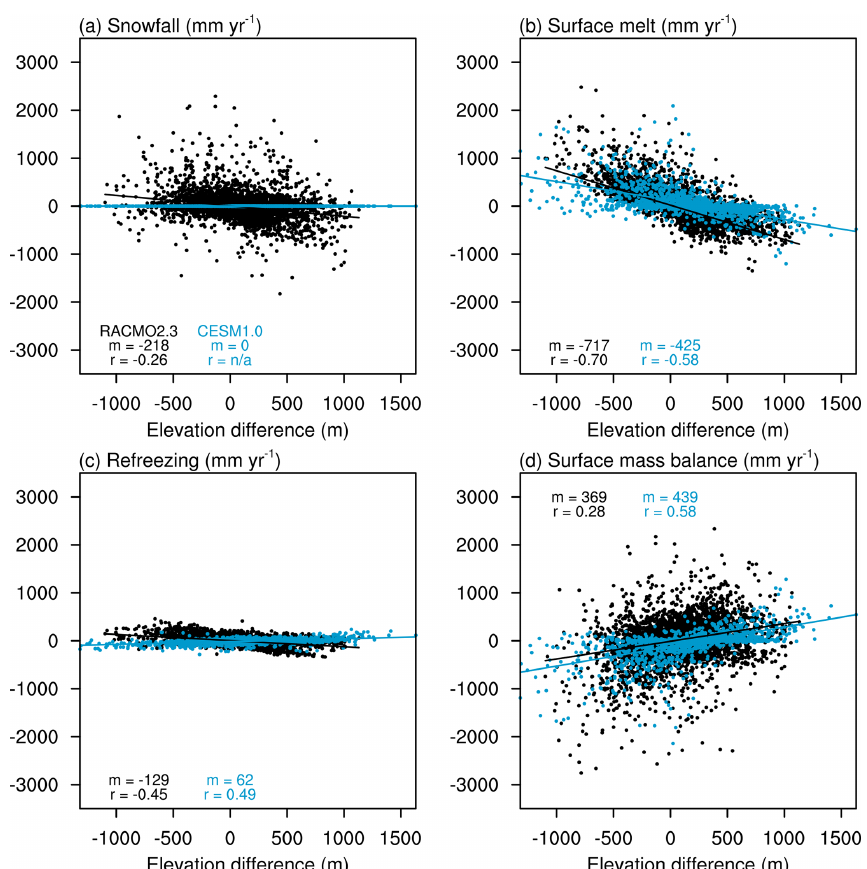
Figure 2. Same as Fig. 1 but for annual SMB components from EC-6K (blue) and RACMO2.3 (black). (a) Snowfall (mmyr − 1 ), (b) surface melt (mmyr − 1 ), (c) refreezing (mmyr − 1 ), and (d) surface mass balance (mmyr − 1 ). Surface mass balance is the sum of snowfall (a) and refreezing (c) minus the surface melt (b) and sublimation (not shown). The lines represent least-squares linear regressions. The annotated m is the least-squares linear regression gradient (mmyr − 1 km − 1 ); r is the correlation